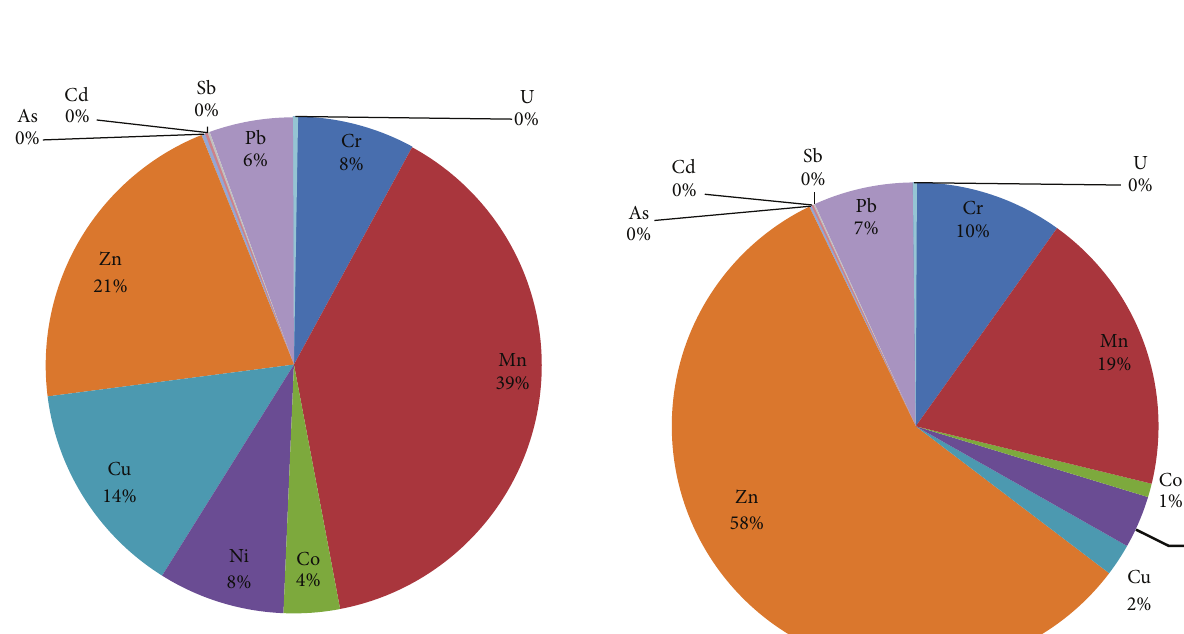
Figure3:Distributionoftracemetalsindustsamplescollectedfrom School C.